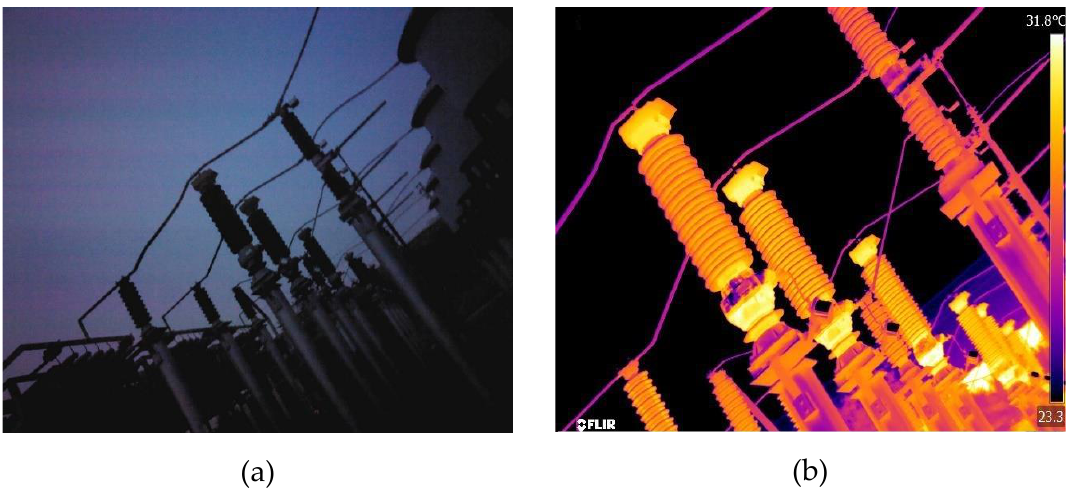
Figure 1. Thermal images of power substation equipment: ( a ) Visible light image. ( b ) Zoomed in infrared thermal image.